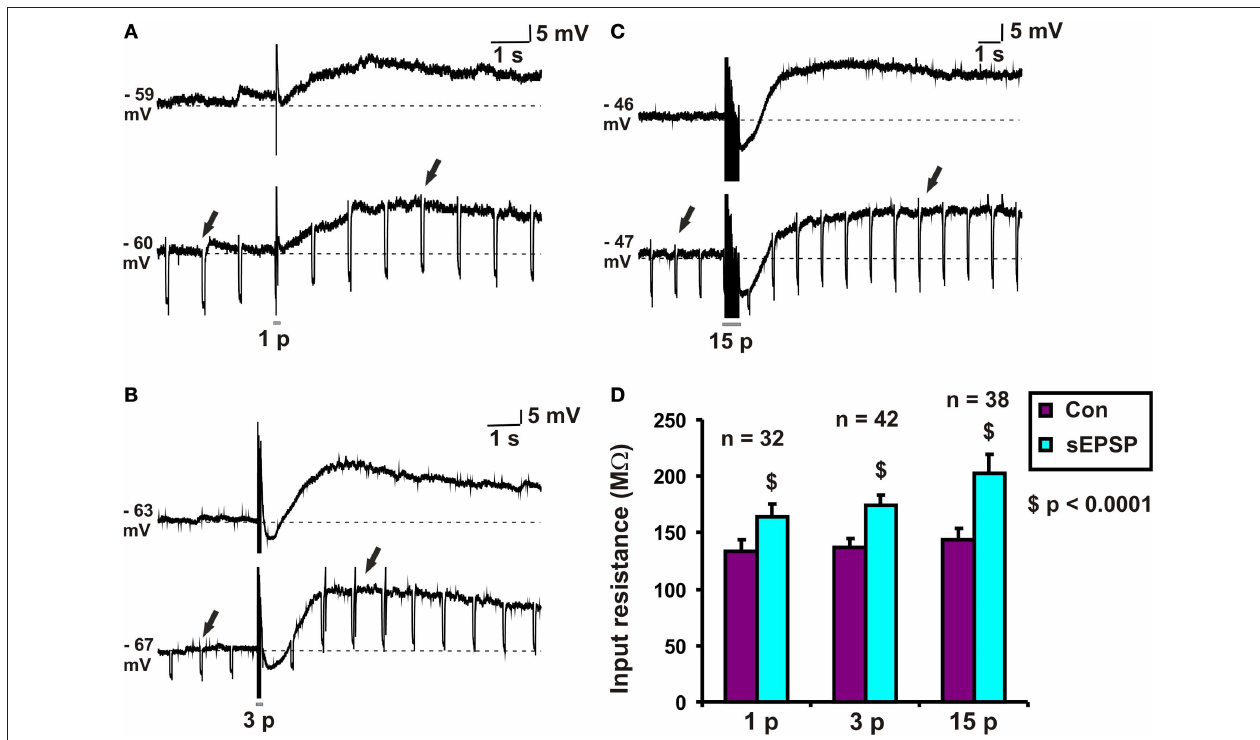
FiGuRE 1 | input resistance associated with slow EPSPs. Examples of (A) 1 pulse, (B) 3 pulse and (C) 15 pulse evoked slow EPSPs in a submucosal neuron. (D) Quantified data comparing input resistance at baseline (arrows) and that associated with 1, 3 and 15 pulse slow EPSPs